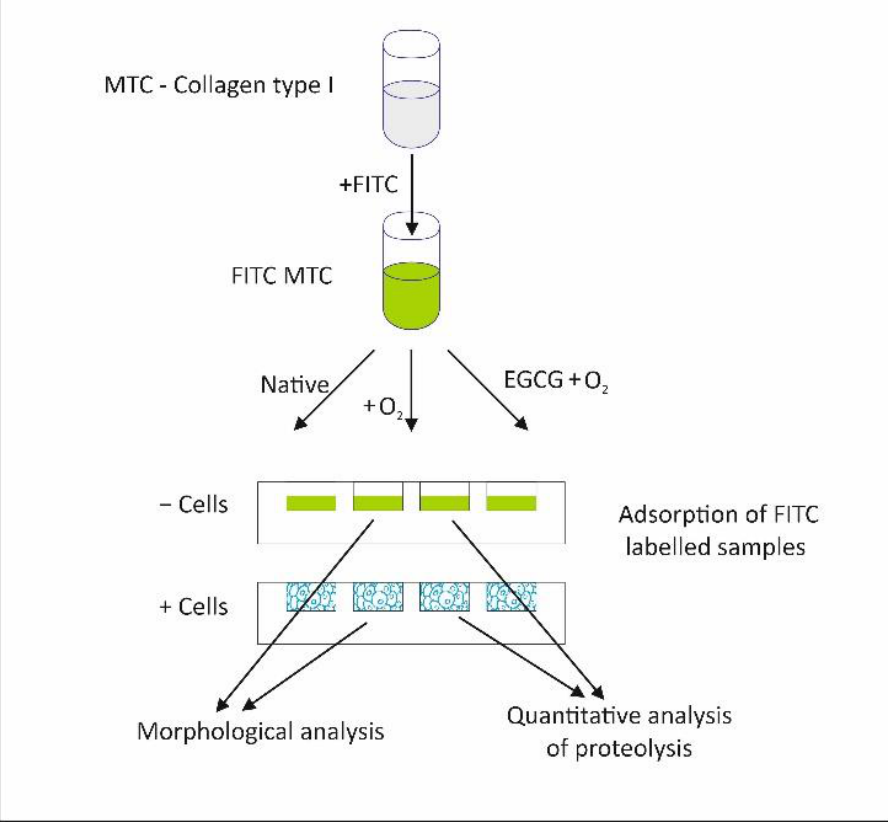
Figure 1. Overall experimental